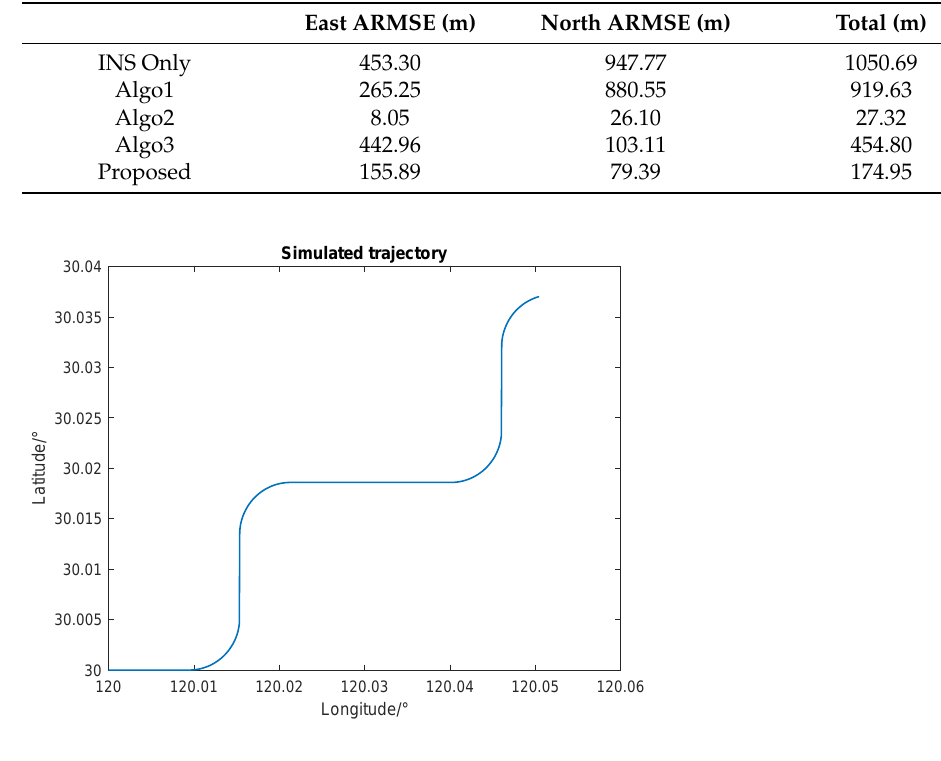
Figure 10. The simulating trajectory.